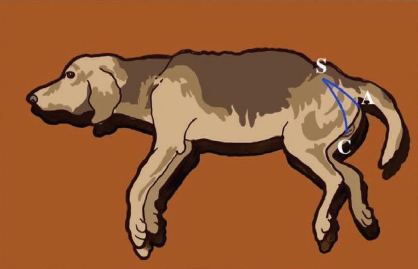
Figure 3: Te blue line indicates the distance from the recording site to the stimulation site, which is referred to as the external anal sphincter-S1-clitoris. (A) Anal sphincter, (B) S1, and (C)